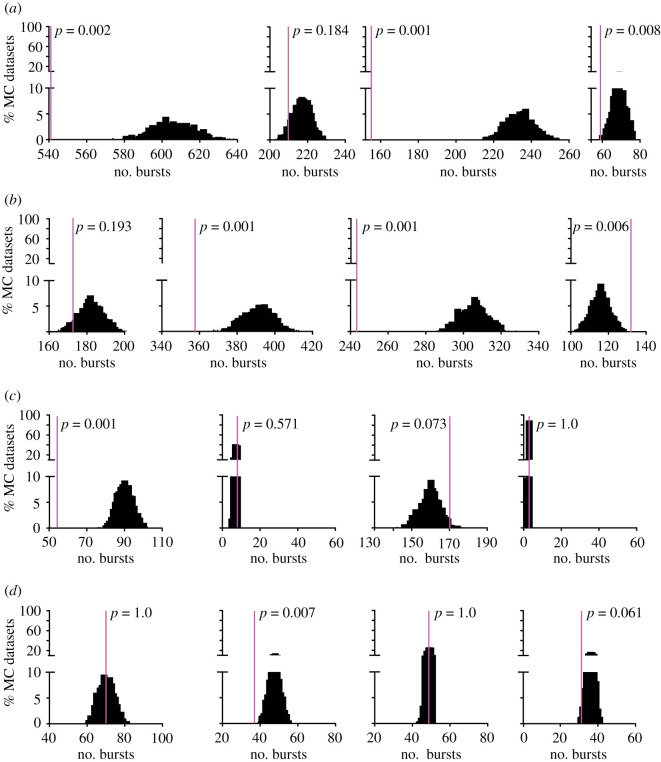
Representative examples from each group of the distribution of the number of bursts detected by the VBW algorithm with a window of 360 ms in the 1000 MC datasets versus original data (magenta line). (a) three-week-old vehicle; (b) three-week-old PNA; (c) adult vehicle; (d) adult PNA. p-values are from cell versus itself analysis comparing original data to its MC dataset distribution. X-axis scale is consistent; range of values differs.